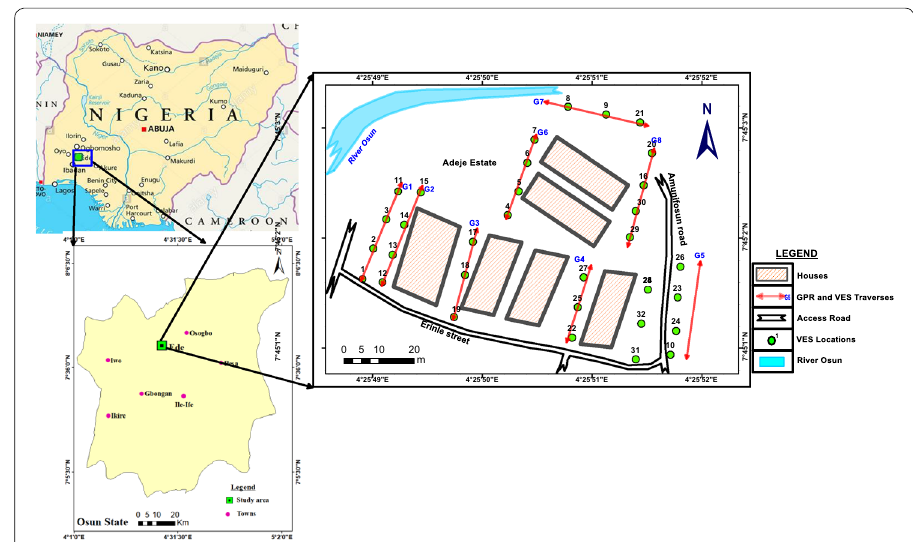
Fig. 2 Layout and geophysical data acquisition map of the study area, Erinle